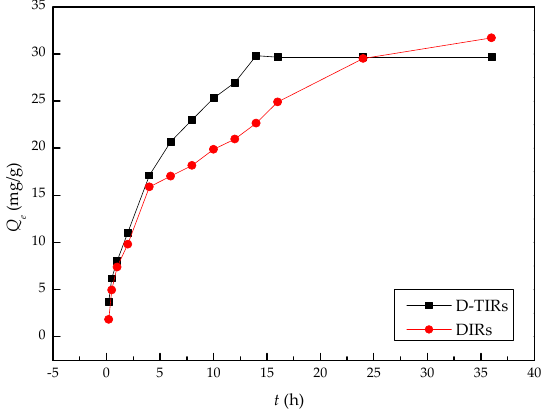
Figure 5. Absorption capacity of SIRs for V(IV) at different time.